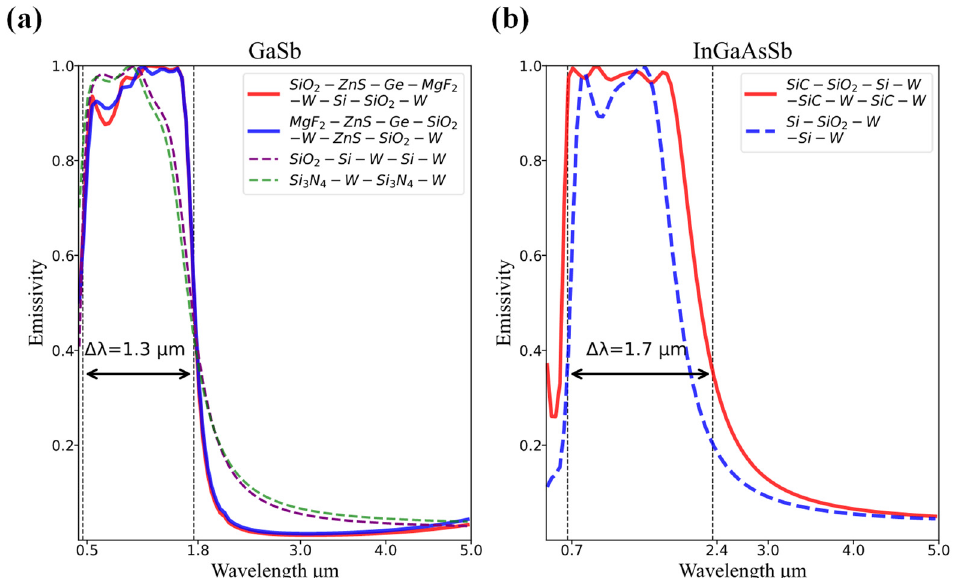
Figure 5. The emission spectrum of different optimal structures including the optimization of the structures in [41,70] using BOnSA for GaSb PV cell ( a ) and for InGaAsSb PV cell ( b ).